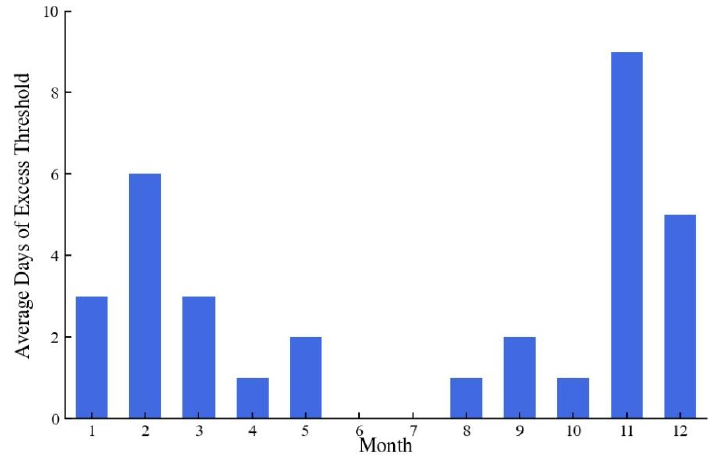
Figure 2. Average days of excess chlorine level for each month.